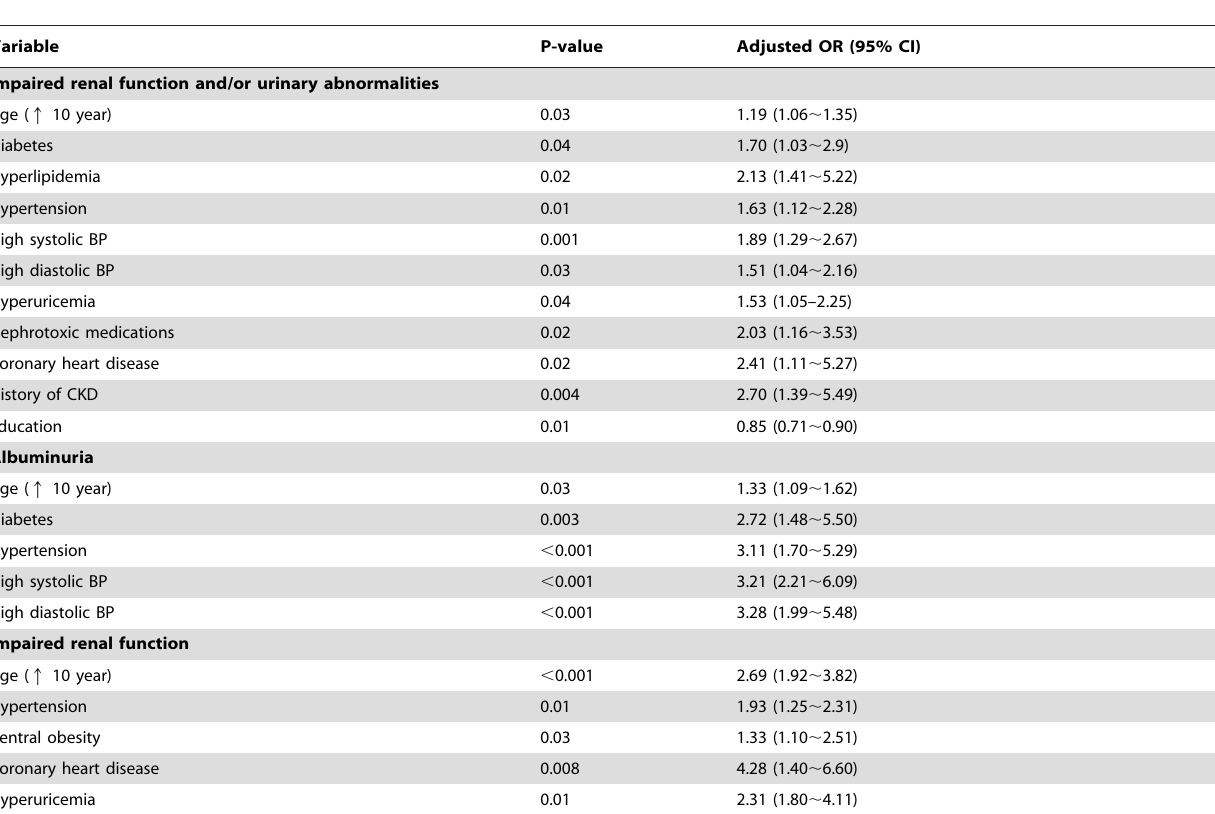
Table 3. Adjusted OR for the presence of impaired renal function and/or urinary abnormalities, albuminuria or impaired renal